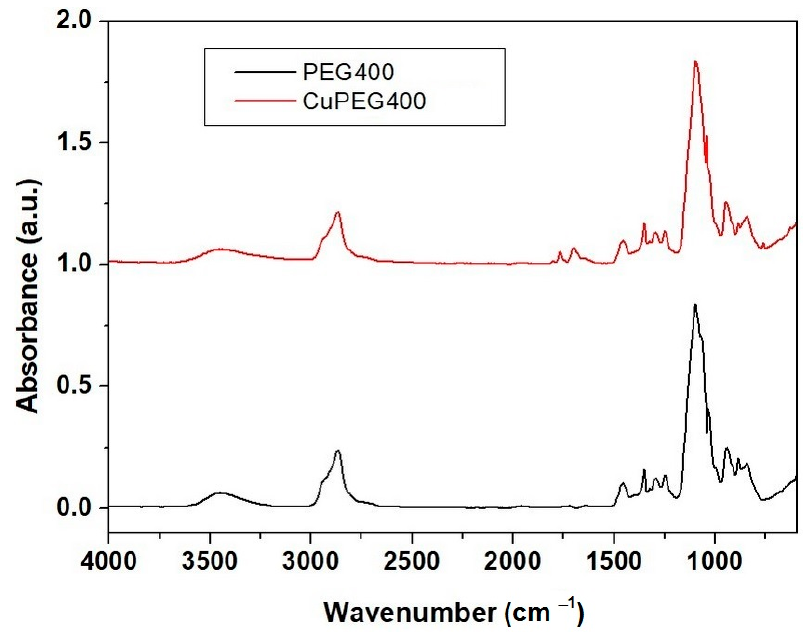
Figure 3. The FTIR-ATR spectra of Cu-PEG 400 and PEG 400.